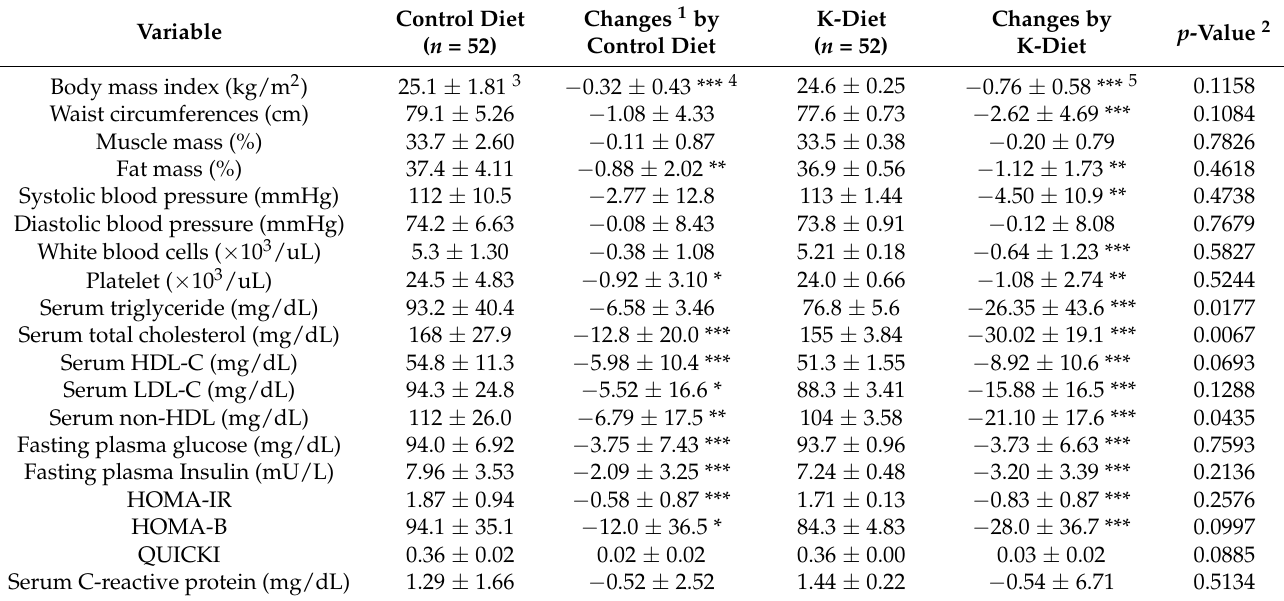
Table 4. Anthropometric and biochemical parameters in the control diet and K-diet groups after a 4-week intervention.